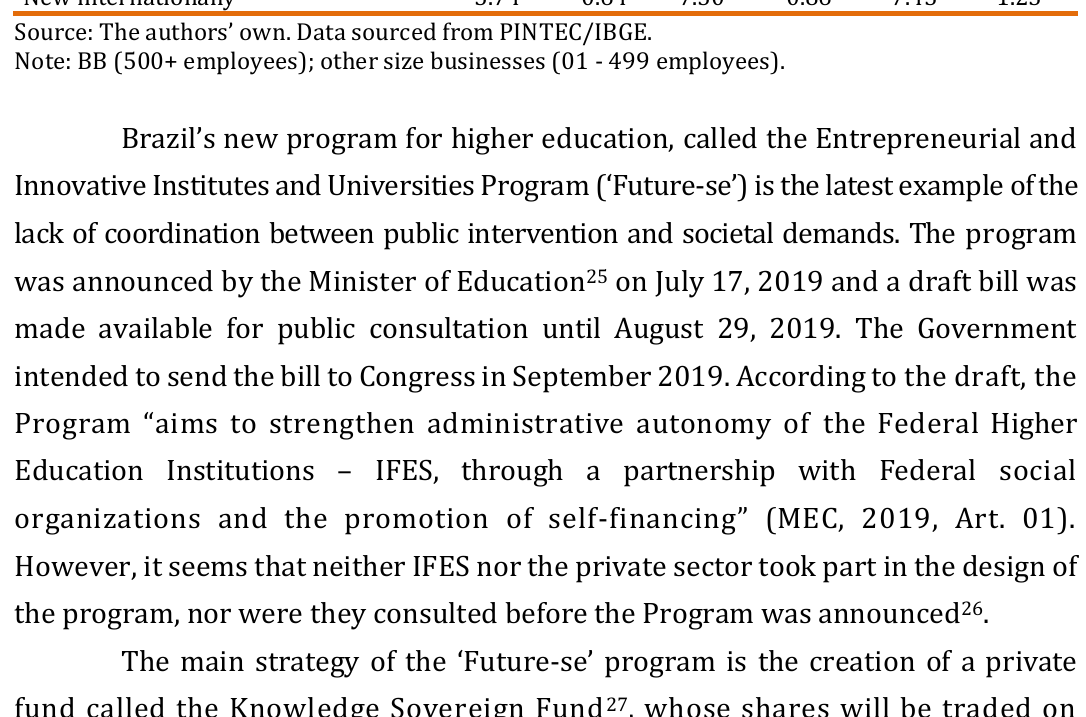
Table 05 . Degree of novelty of main products and processes implemented by innovative businesses, by size, Brazil, 2013, 2014 and 2017 New to the firm but not nationally 25.19 59.73 26.57 37.90 38.22 New nationally but not internationally 25.22 New